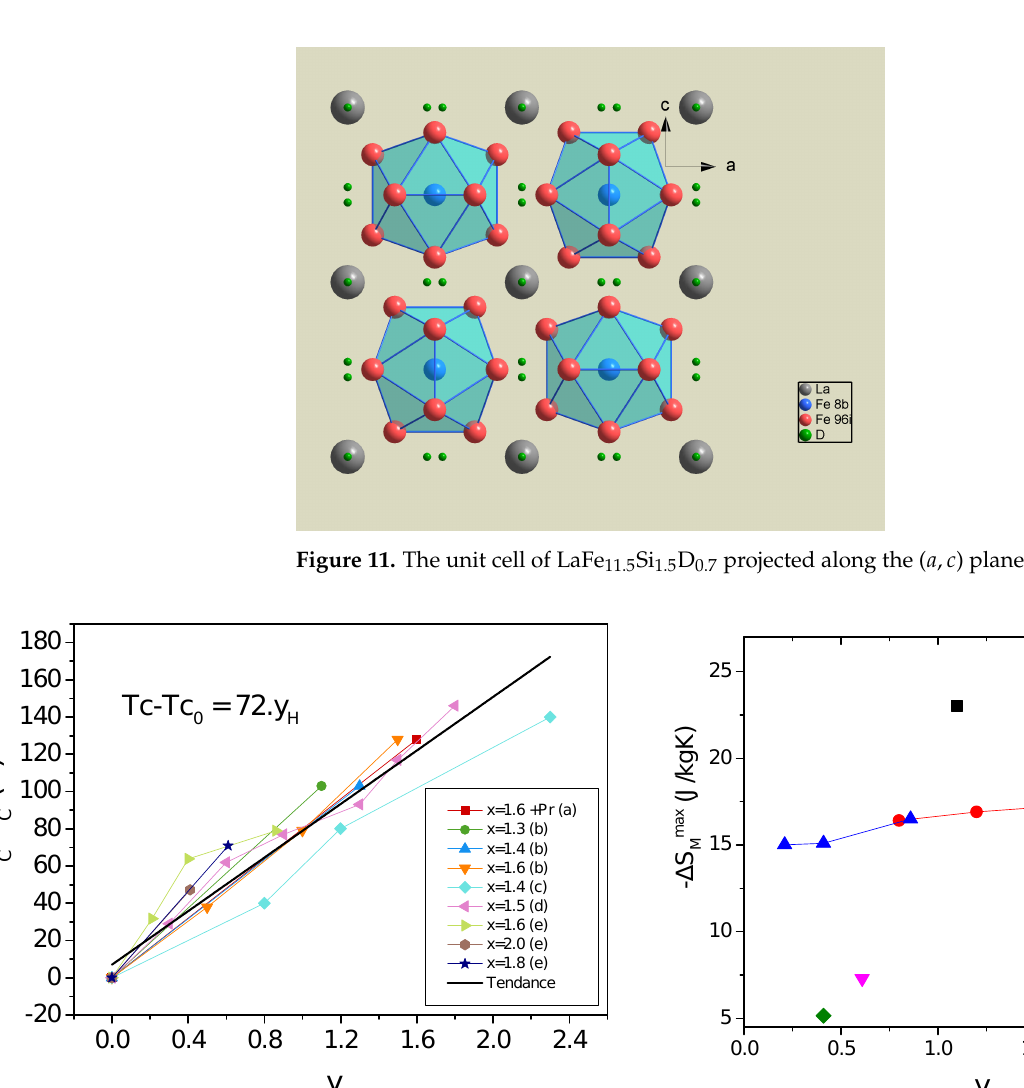
vs. the insertion rate y H for LaFe 13 − x Si x H y (a) [35], M